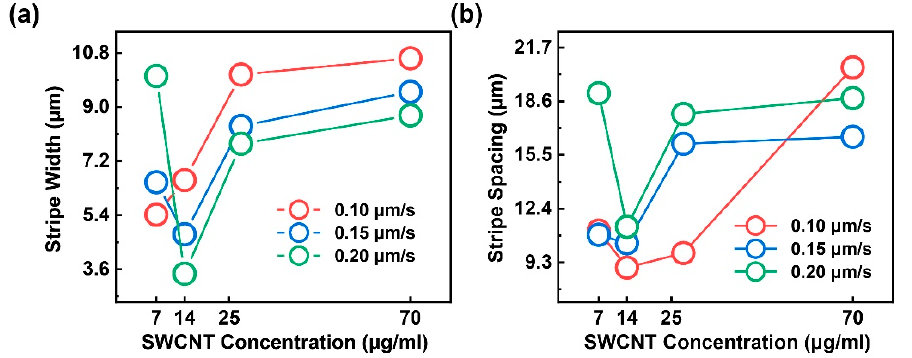
Figure 3. ( a ) shows the SWCNT stripes width as functions of the concentration and withdraw speed; ( b ) is the SWCNT stripe spacing as functions of the concentration and withdraw speed.